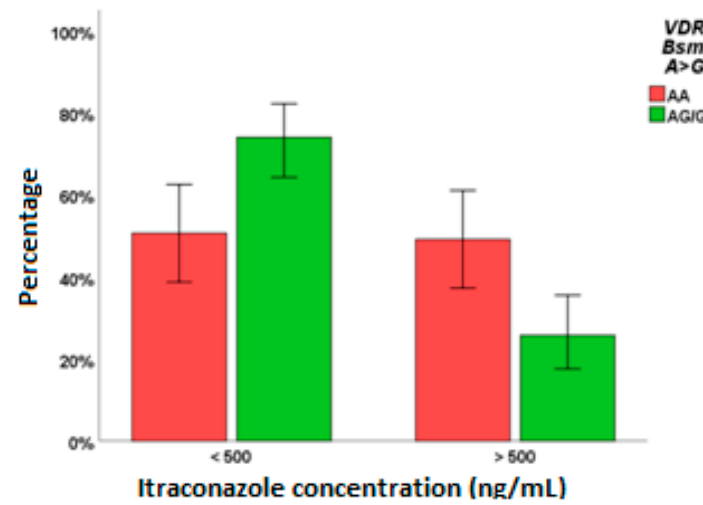
Figure 3. Influence of VDR Cdx2 A > G SNP on posaconazole exposure. 2.3. Itraconazole A total of 143 pediatric (median age = 9 years) patients were analyzed: their charac- teristics are resumed in Table 1. Females were 87, and the medium BMI was 16.5 kg/m 2 . Concerning age, BMI, creatin levels, and ITC plasma concentrations, no correlations were highlighted. VDR BsmI AG/GG ( p = 0.002, Figure 4), VDR ApaI AA ( p = 0.035), and CYP24A1 8620 AG/GG ( p = 0.020) affected ITC levels.